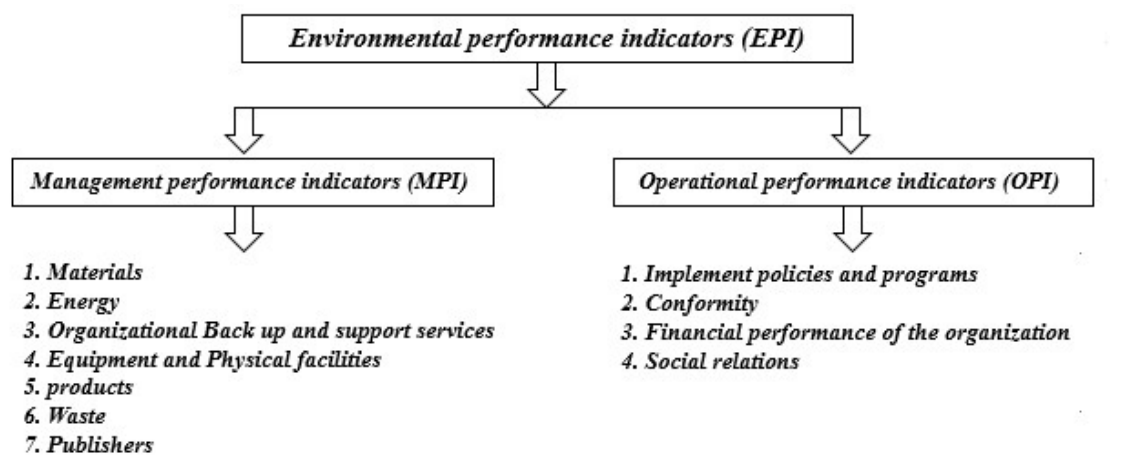
Figure 4. The block diagram of the Environmental Performance Evaluation (EPE) [34]